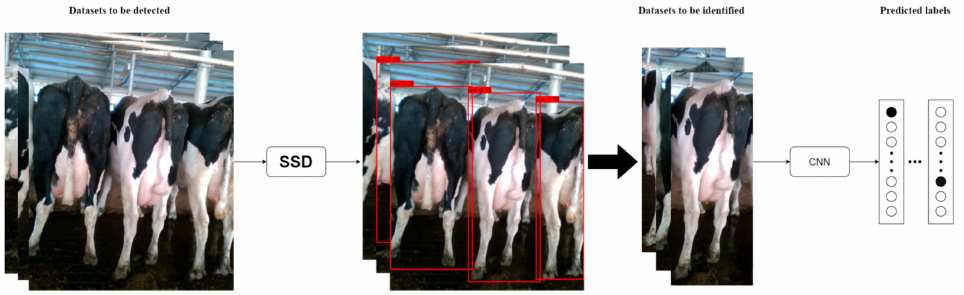
Figure 3. Flowchart of the cow rump identification